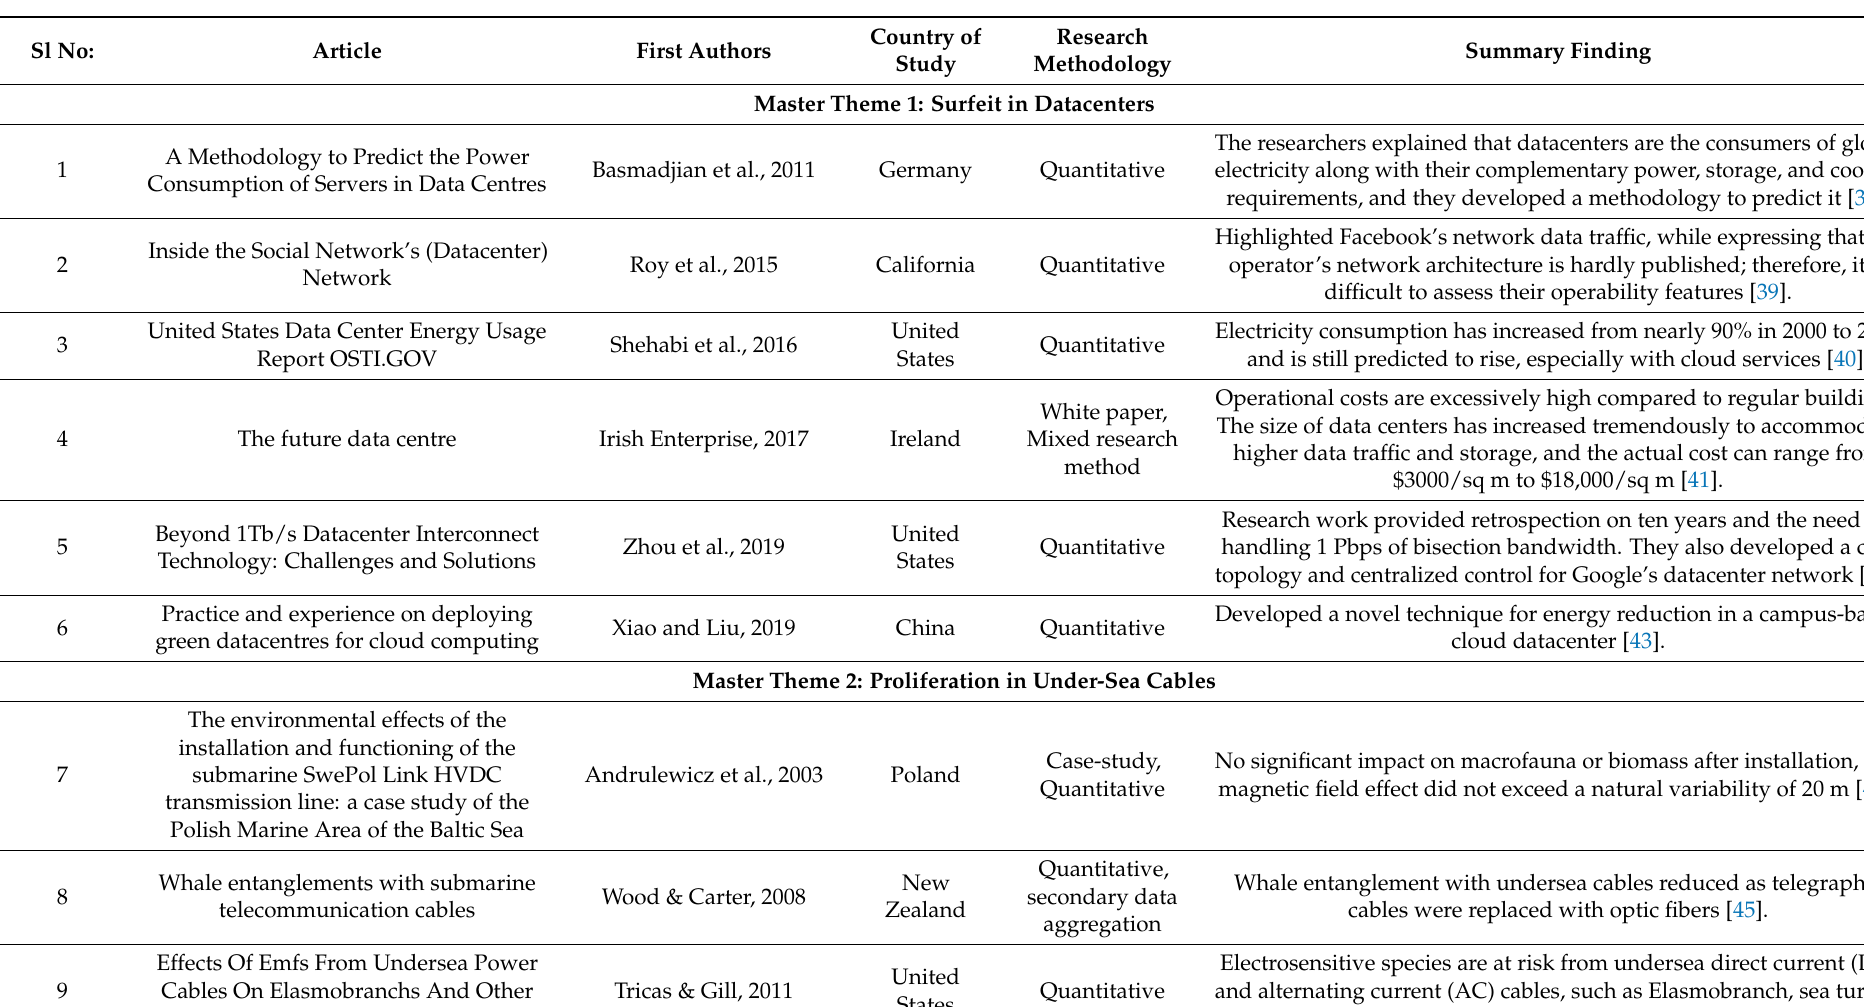
Table 1. Summary finding of selected